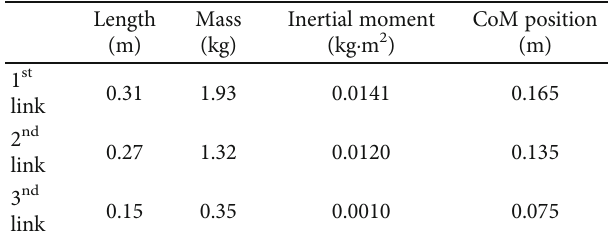
Figure 3: Controller block diagram and system critic rules. Table 2: Numerical values of the